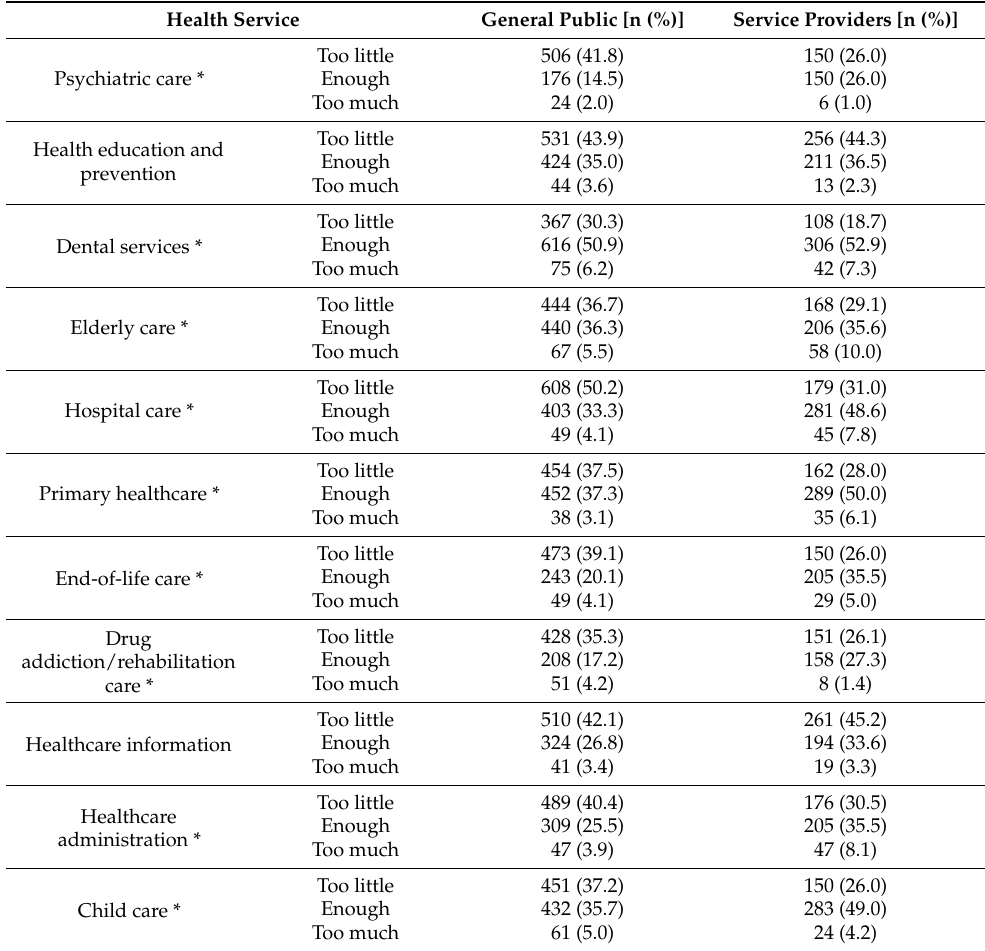
Table 9. Respondents’ perception on the adequacy of resource